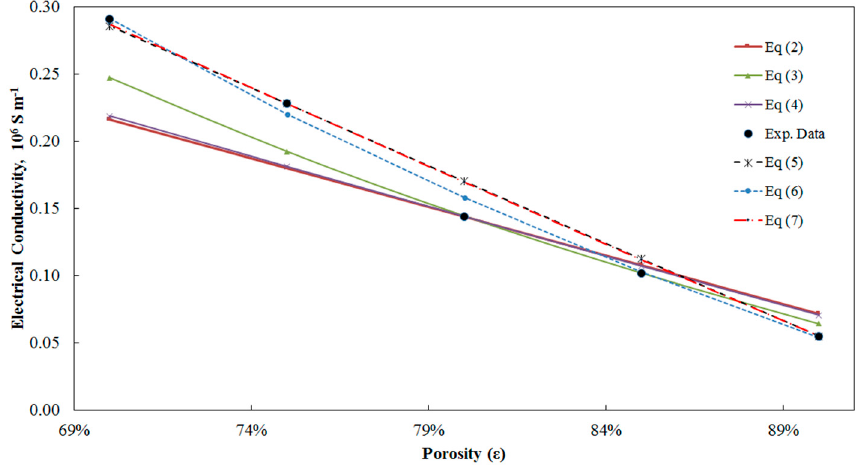
Figure 3. Different models fitted to experimental data from Zhou et al. [40].